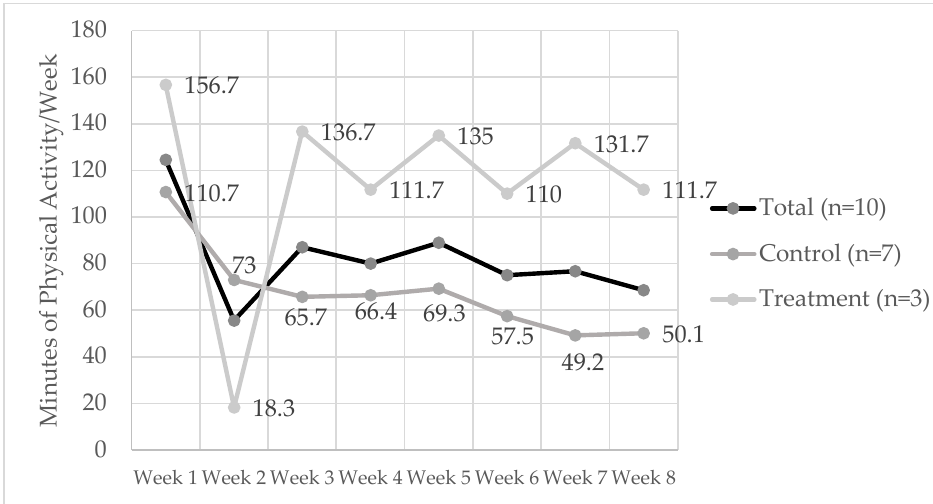
Figure 1. Physical activity (minutes/week) in study participants (n = 10) over 8 weeks. Figure 2 shows changes in anthropometric measures following the 8-week interven- tion (n = 10). In all participants, there was an average weight loss of 4.2 pounds ( p < 0.05). Weight loss was greater in the treatment group compared to the intervention group ( − 3.0% vs. − 2.0%), although differences did not reach statistical significance due to the small sam- ple size. Figure 2 also shows weight change by recommendation adherence. Those who adhered to their dietary goals throughout the eight weeks lost more weight than those who did not ( − 3.1% vs. − 1.5%), although it was not statistically significant. Changes in waist circumference were minimal due to the short follow-up time.